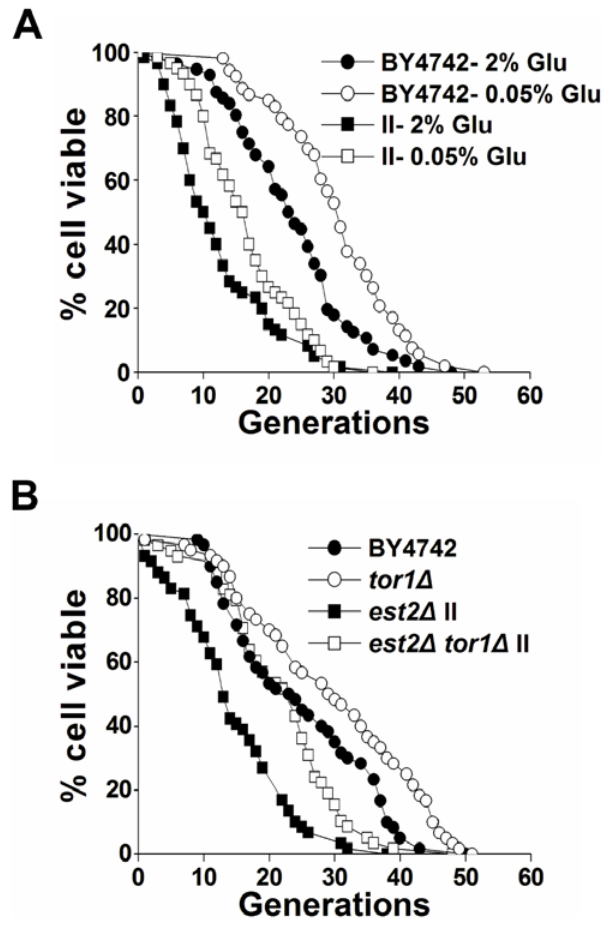
Figure 3. Calorie restriction or inactivation of the TOR pathway extends the life span of type II survivors. (A) Calorie restriction in est2 D type II survivors. Mean life span of strains shown: BY4742-2% Glucose, 23.6 6 9.3 (n=56); BY4742-0.05% Glucose, 30.5 6 9.2 (n=53); est2 D type II-2% Glucose, 12.6 6 8.0 (n=60); est2 D type II-0.05% Glucose, 16.7 6 7.2 (n=60). (B) Life span analysis in est2 D type II survivors with TOR1 deletion. Mean life span of strains shown: BY4742, 24.8 6 11.1 (n=60); tor1 D , 29.4 6 12.9 (n=60); est2 D type II, 14.6 6 8.6 (n=59); tor1 D est2 D type II, 22.0 6 9.1 (n=58).